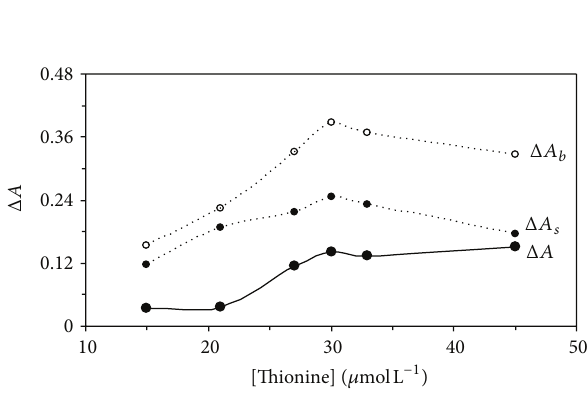
Figure1:Effectofsulfuricacidconcentrationontherateofuninhib- ited ( Δ𝐴 𝑏 ) and inhibited ( Δ𝐴 𝑠 ) reactions and response ( Δ𝐴 ). (Con- ditions: sulfuric acid, 0.12–0.48 mol L −1 ; thionine, 27.0 𝜇 molL −1 ; dopamine, 3.0 𝜇 gmL −1 ; bromate, 0.5 mmolL −1 ; 25 ∘ C and 270s.)